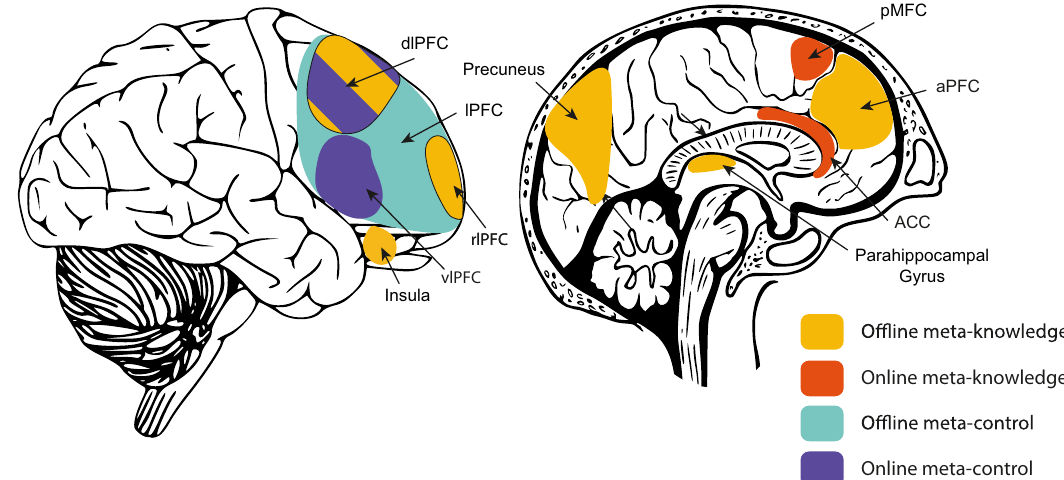
Fig. 5 Brain regions associated with metacognition in the cognitive neuroscience literature. The regions are divided into online meta- knowledge and meta-control, and of fl ine meta-knowledge and meta-control following the distinctions introduced earlier. Some regions have been reported to be related to both of fl ine and online processes and are therefore given a striped